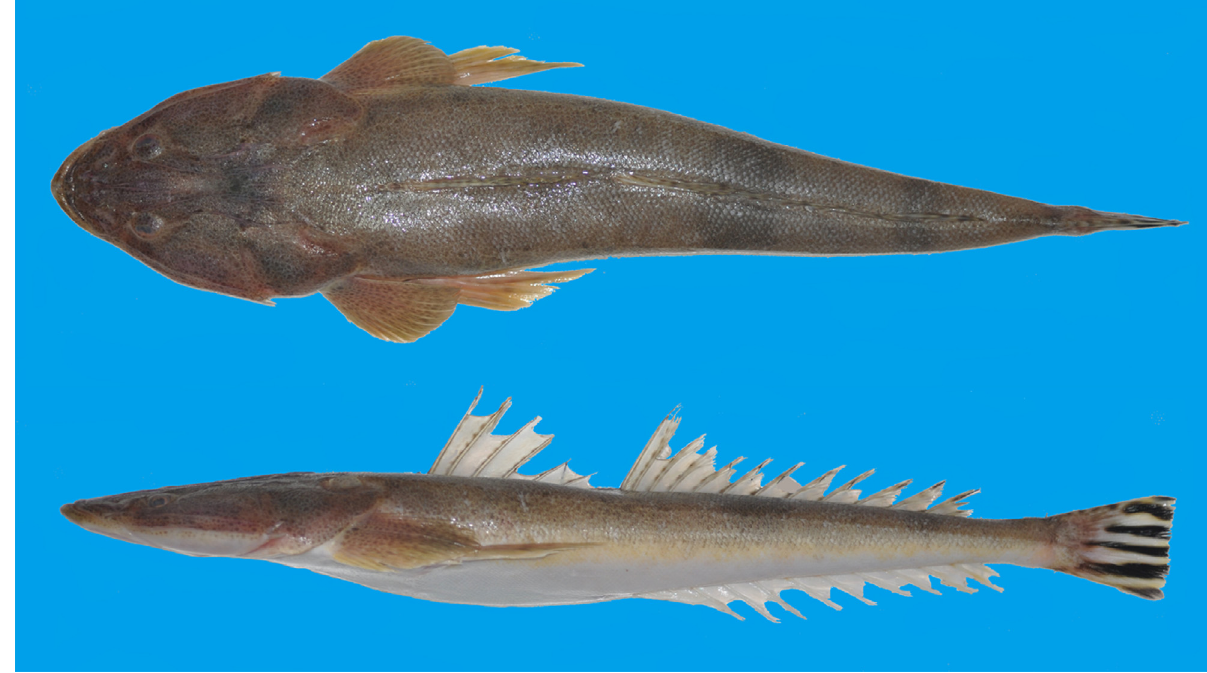
Fig. 2. Lateral (upper) and dorsal (lower) views of Platycephalus cultellatus , 347.3mm